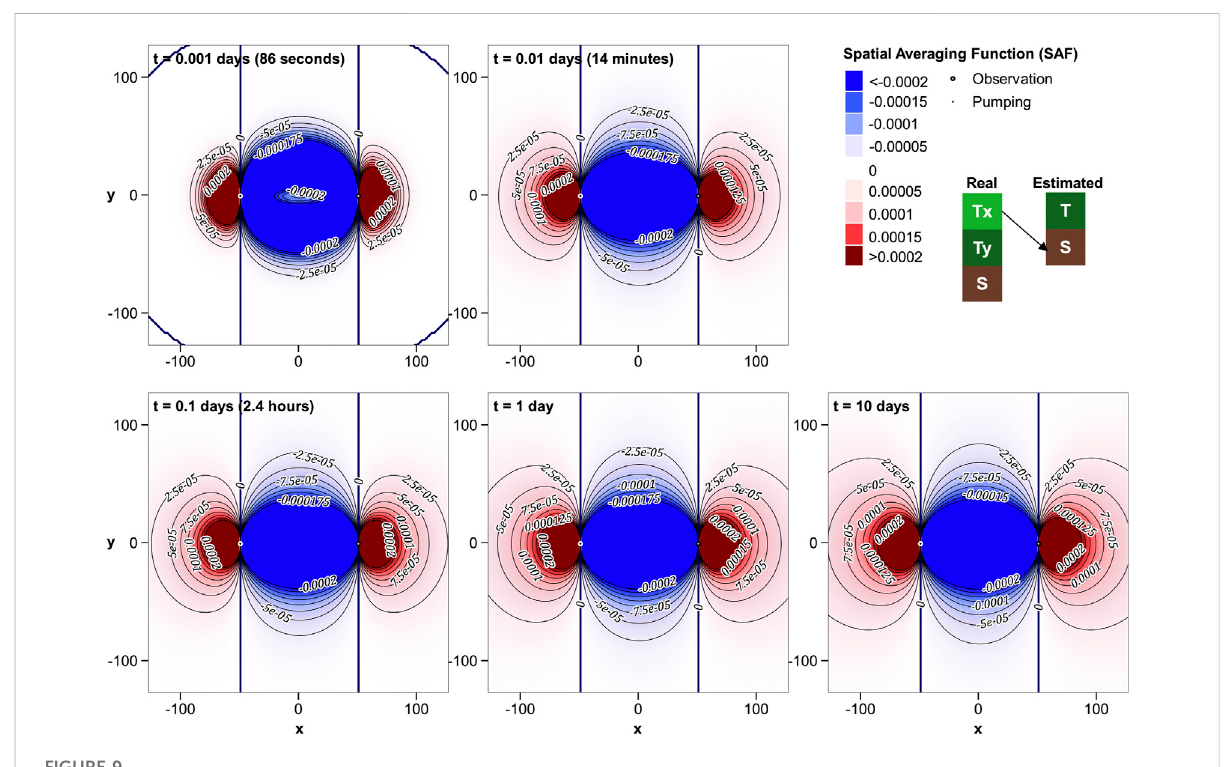
FIGURE 9 R ′ S − Tx for separated wells at fi ve different